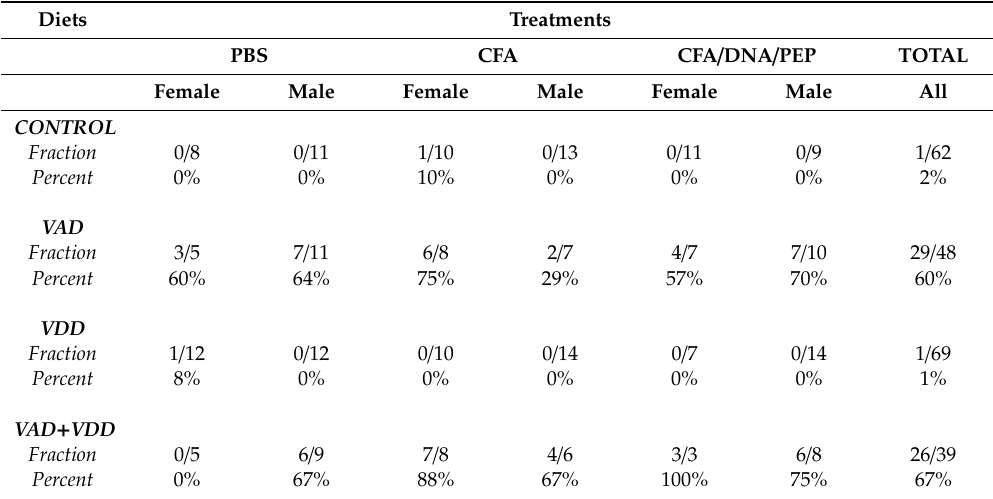
Table 1. Frequent nephropathies in animals fed VAD or VAD + VDD